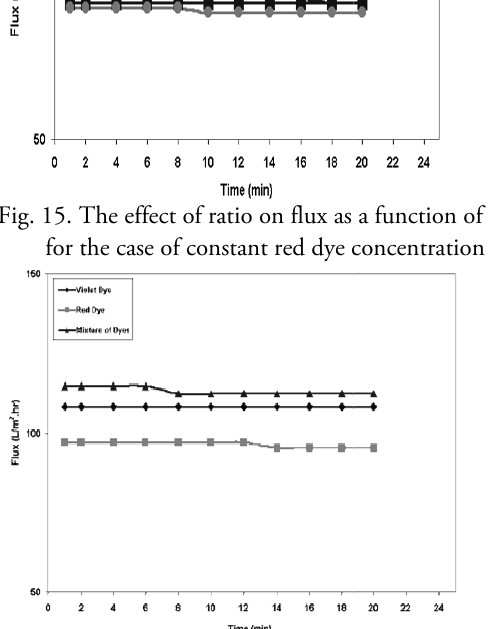
of mixture of d ct of the two d